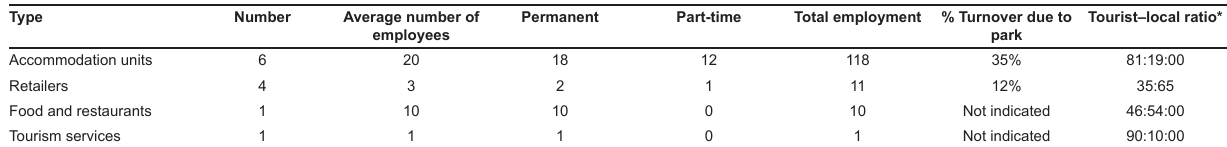
TABLE 5 Breakdown of businesses in the area and employment levels